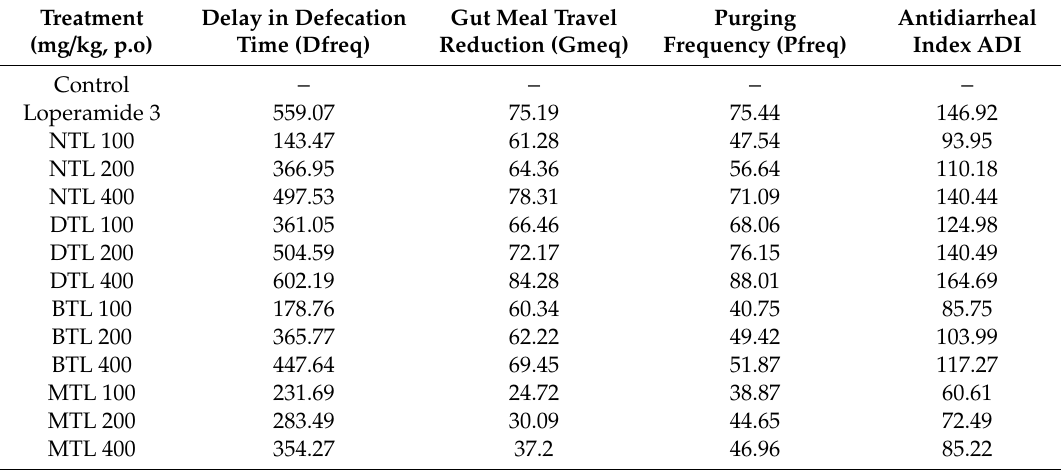
Table 5. In vivo antidiarrheal index value of the methanol extract of T. leucostaphylum leaves and its derived fractions.